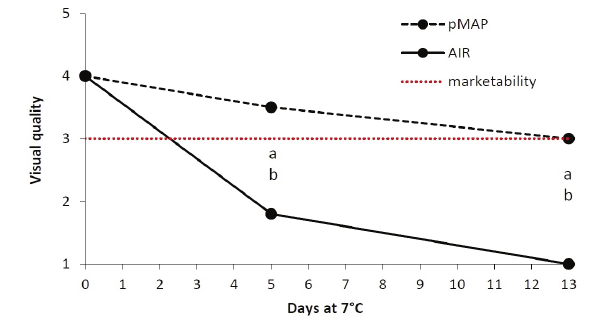
Fig. 2 ­ Changes in visual quality of goji berries stored in pMAP or AIR for 13 days at 7°C (±1). Values are means of three replicates for each packaging condition at each storage time. Within the same storage time, different letters indicate statistical differences, P≤0.05. Visual quality score: 5=excellent, no defects; 4=very good, minor defects; 3=fair, moderate defects; 2=poor, major defects; 1=inedible.